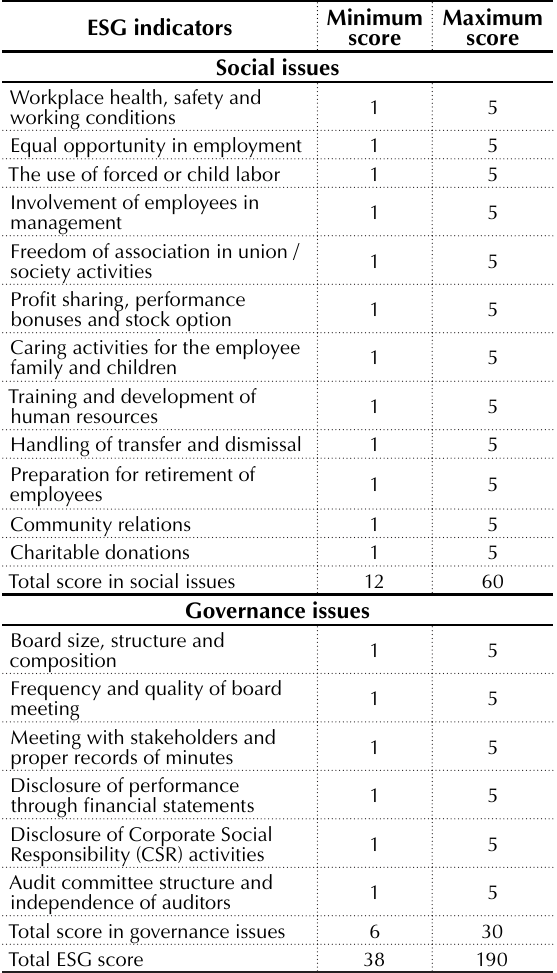
Table 1 (cont.). Factors considered in